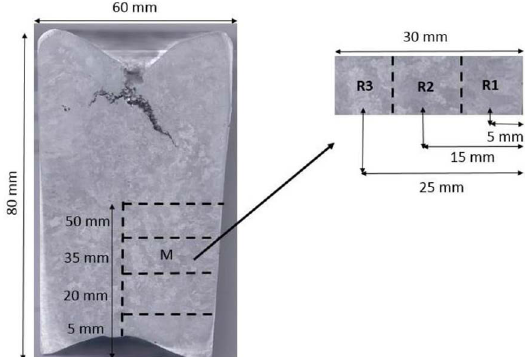
Figure 3. Removal of the cast ingot samples for the measurements secondary dendrite spacing and